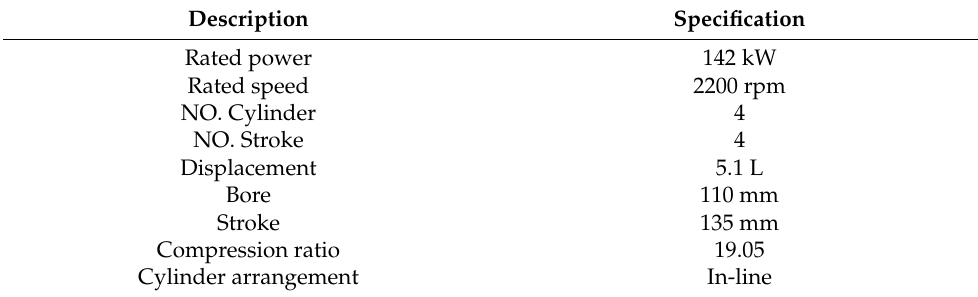
Table 1. Specifications of the test engine.